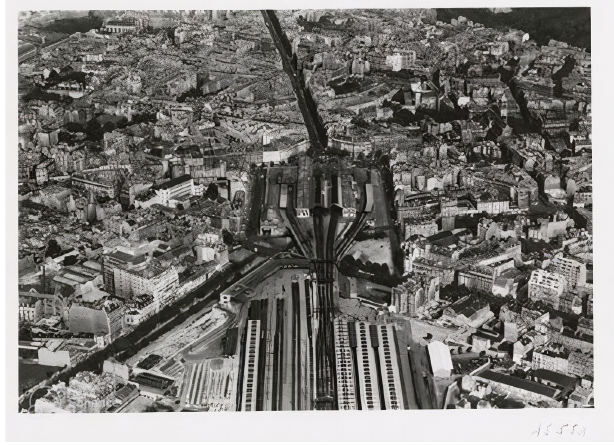
Figure 7. Gare Montparnasse. Aerial view (Henrard, Roger). PH344 ‐ 15551. Paris Musées. Creative Commons Zero.